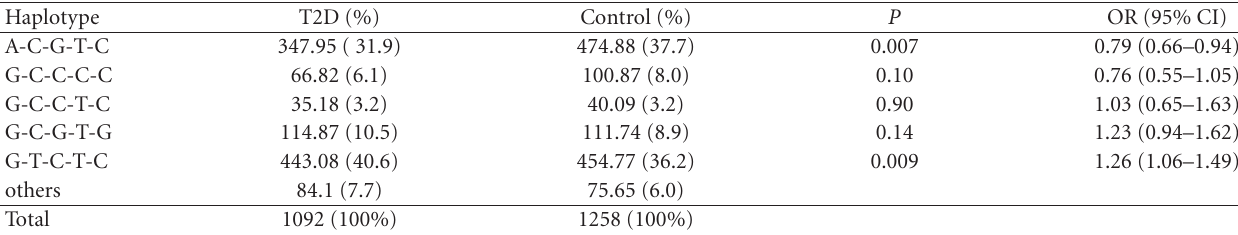
Table 4: Common haplotypes in the MFN2 gene.